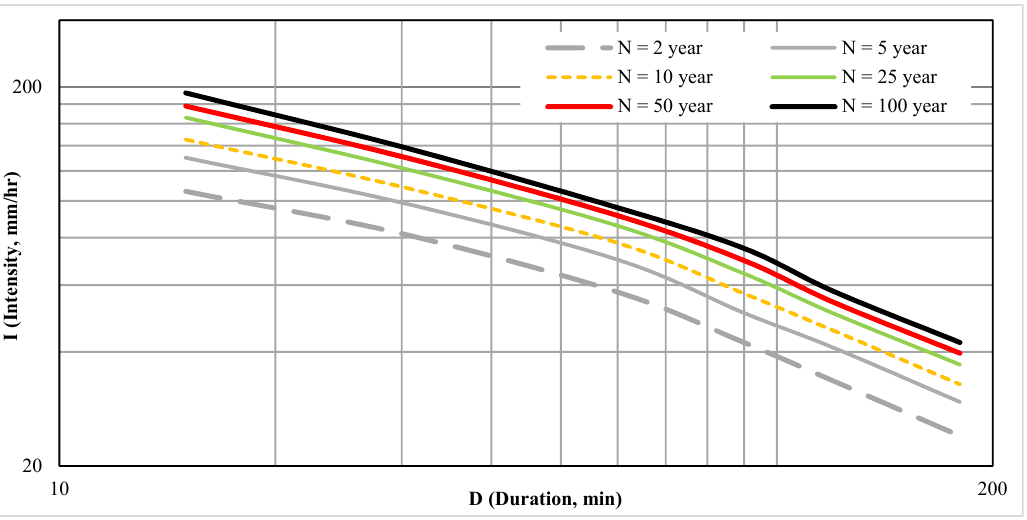
Figure 6. Development of IDF rainfall curve from CDF rainfall curve for various durations.